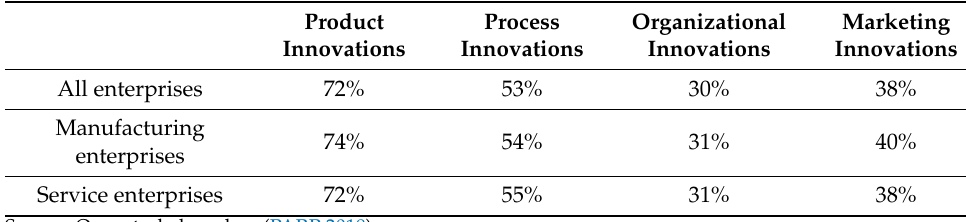
Table 1. Classification of planned innovations, declared during the first measurement of the enter- prises.